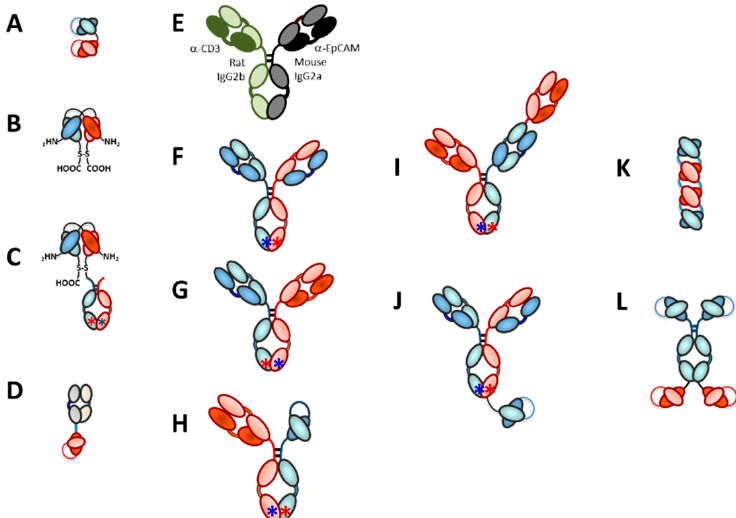
Figure 7. Examples of bispecific antibody platforms used to make clinical stage TRBAs. ( A ) Bispecific T-cell engager (BiTE ® ) [45]; ( B ) dual affinity retargeting (DART ® ) antibody [153]; ( C ) DART ® -Fc for elongated half-life in vivo [154]; ( D ) TCR fused to scFv called immune-mobilizing monoclonal TCRs against cancer (ImmTAC) [155]; ( E ) mouse/rat hybrid IgG [53]; ( F ) Asymmetric IgG with common LC [59]; ( G ) Asymmetric IgG with different light chains [156]; ( H ) Asymmetric IgG-like molecule with a Fab arm and an scFv arm to eliminate light chain resorting [157,158]; ( I ) Asymmetric IgG using cross- mab technology for LC fidelity and extra Fab arm to make a 2:1 (target cell antigen:CD3 ε ) antibody